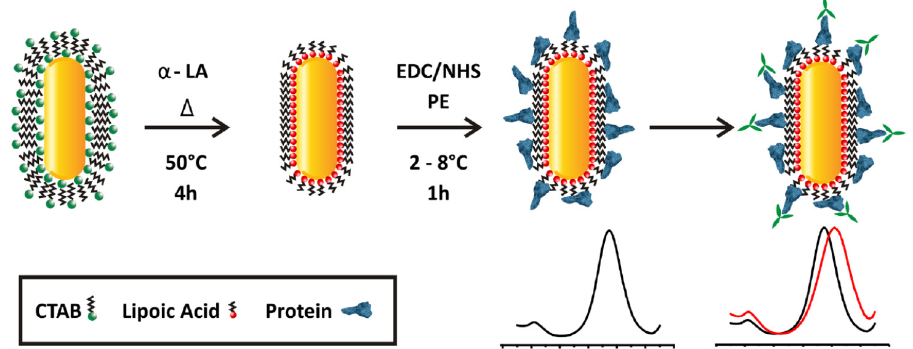
Figure 4. Modification steps of Dengue virus localized surface plasmon resonance (LSPR) sensor surface. Republished with permission from [82]; permission conveyed through Copyright Clearance Center, Inc.